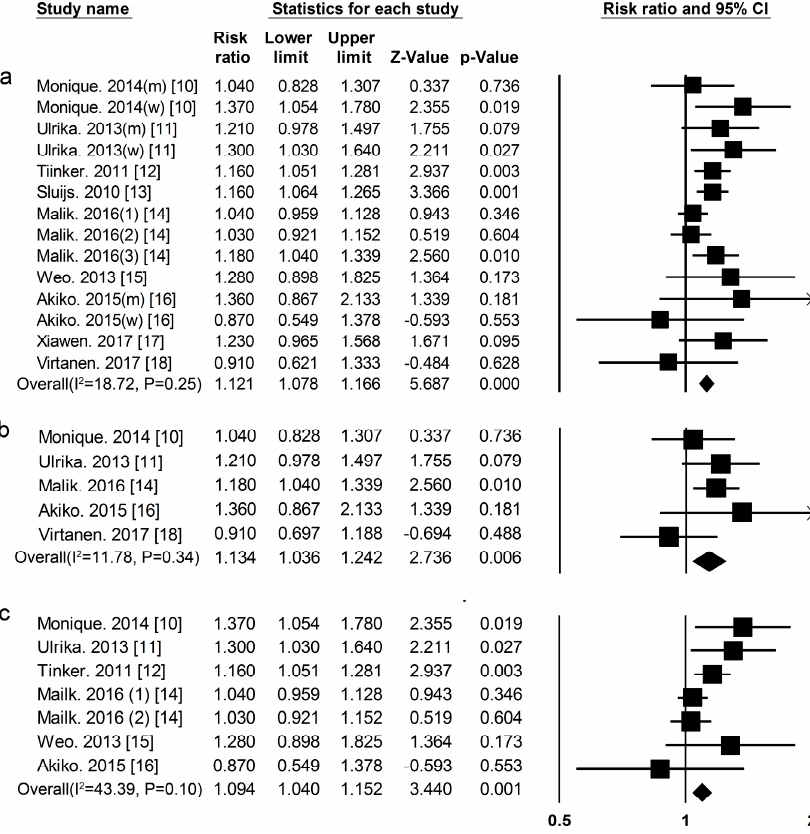
Figure 2. Total protein and type 2 diabetes relative risks (RRs) for ( a ) the highest vs. the lowest intake in all subjects and ( b ) the highest vs. the lowest intake in men ( c ) the highest vs. the lowest intake in women. The RR of each study is represented by a square, 95% CI are represented by the horizontal lines, and the diamond represents the estimate and its 95% CI.